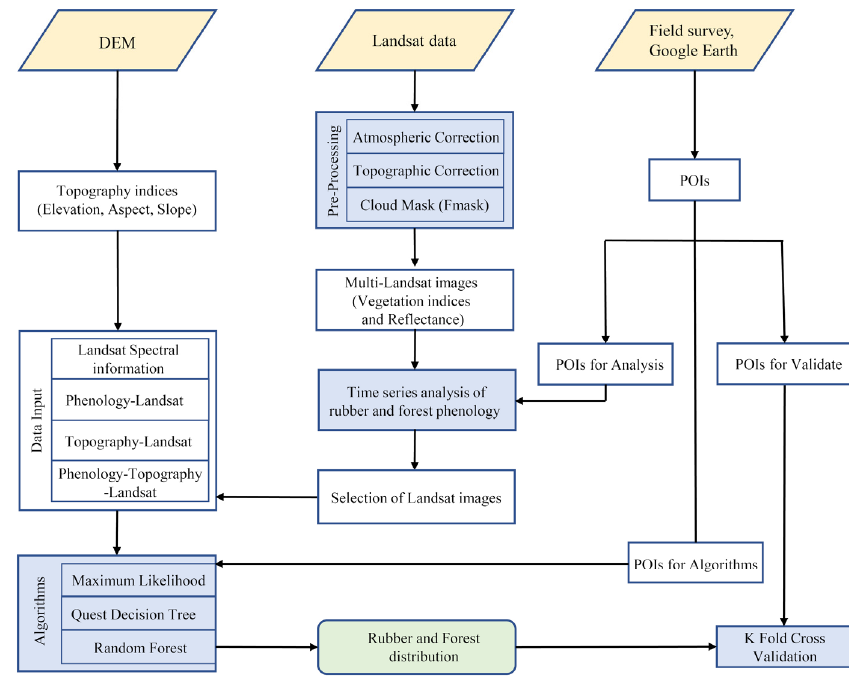
Figure 2. The workflow for mapping the land use and land cover in Xishuangbanna. For the candidate Landsat images, we calculated the Normalized Difference Vegetation Index (NDVI) [33], Enhanced Vegetation Index (EVI) [34], and Land Surface Water